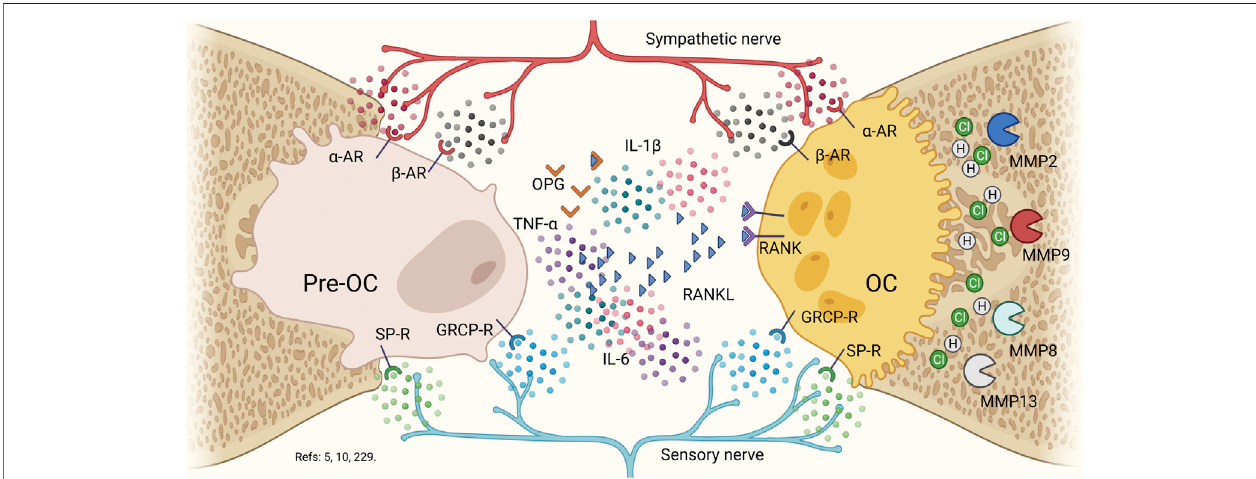
FIGURE 5 | Nervous system in bone biology. Pre-osteoclast and osteoclasts possess α 2-adrenergic, β 2-adrenergic, substance P, and calcitonin gene related peptidesurfacereceptors. Although, the presenceofRANKL iscapable ofallowingtheactivationofosteoclaststoallowthefusionofprecursors,theevidence suggests the role of epinephrine, nor-epinephrine, substance P and the calcitonin gene related peptide in regulating both of formation as bone resorption. In a pro-in fl ammatory context, the presence of nor-epinephrin and epinephrin will produce an increase in osteoclast function and a decrease in osteoblastic function, by decreasing the pre-osteoclast activation. On the contrary, in the presence of substance P or calcitonin gene related peptide, the effect will be higher for bone formation and bone resorption will decrease. Thus, under a distress response, the epinephrine will be activating constantly the pre-osteoclasts and osteoclasts. Osteoclasts will increase their bone-resorptive function by secreting HCl, collagenases (MMP8 and MMP13) and gelatinases (MMP2 and MMP9). Pre-OC: pre-osteoclast, PC: octeoclast, α -AR: α 2-Adrenergic receptor, β -AR: β 2-Adrenergic receptor: SP-R: substance P receptor, GRCP-R: gene-related with calcitonin peptide receptor, OPG. Osteoprotegerin, RANKL: Receptor of the activator of nuclear factor κ B ligand, RANK: Receptor of the activator of nuclear factor κ B, IL: interleukin, MMP: matrix